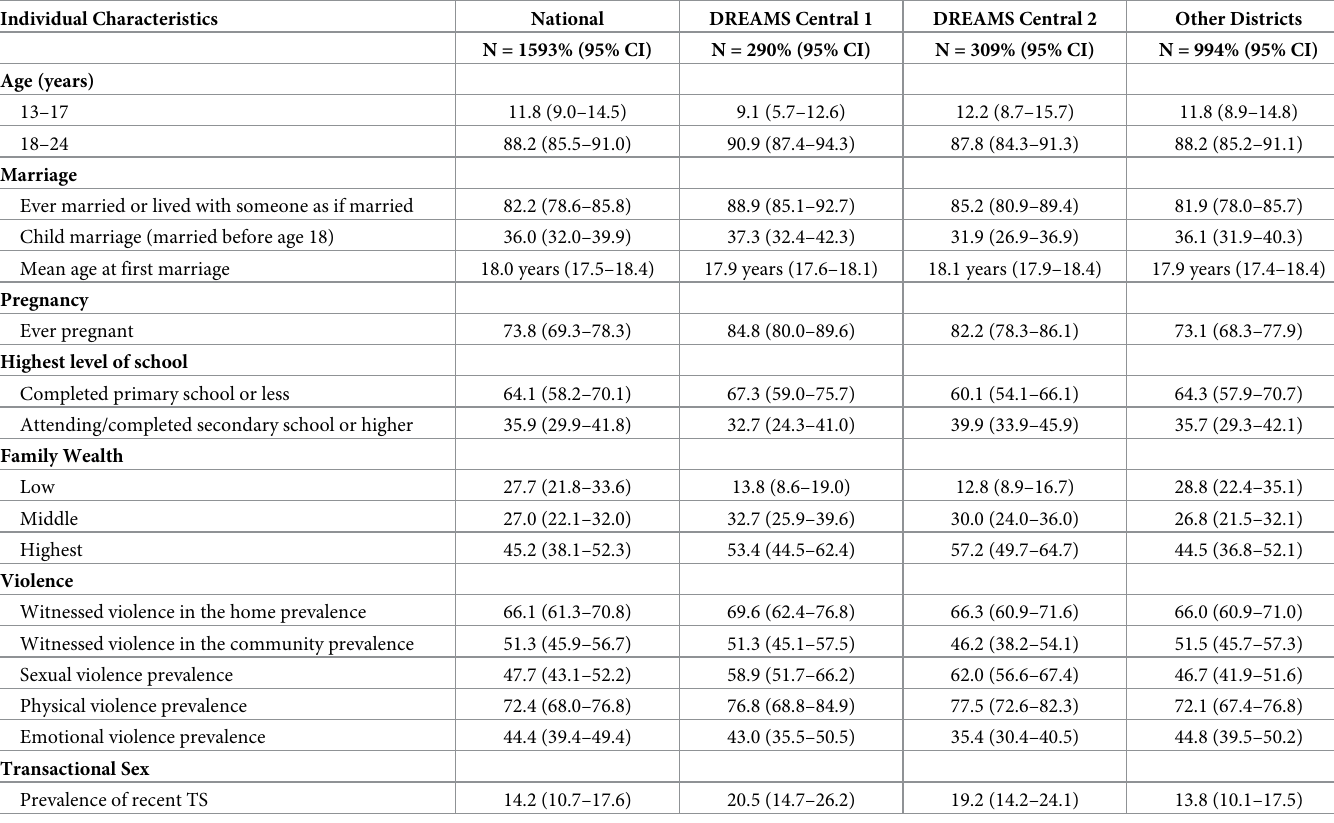
Table 2. Individual characteristics and prevalence of recent transactional sex among sexually active a Ugandan adolescent girls and young women ages 13–24 years